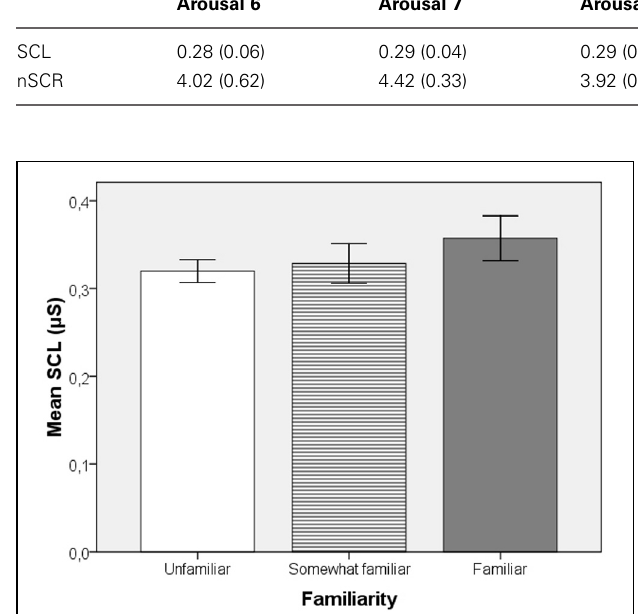
FIGURE 1 | Mean skin conductance level values as a function of familiarity from Experiment 1B. The trend toward higher values with familiarity is not statistically